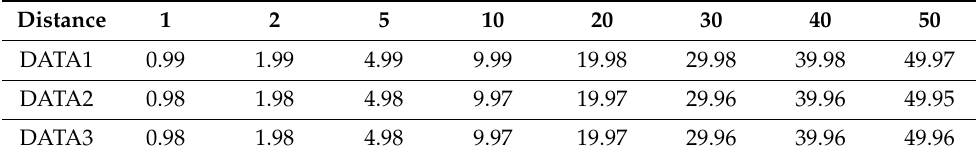
Table 19. The different distance values after correction (unit: